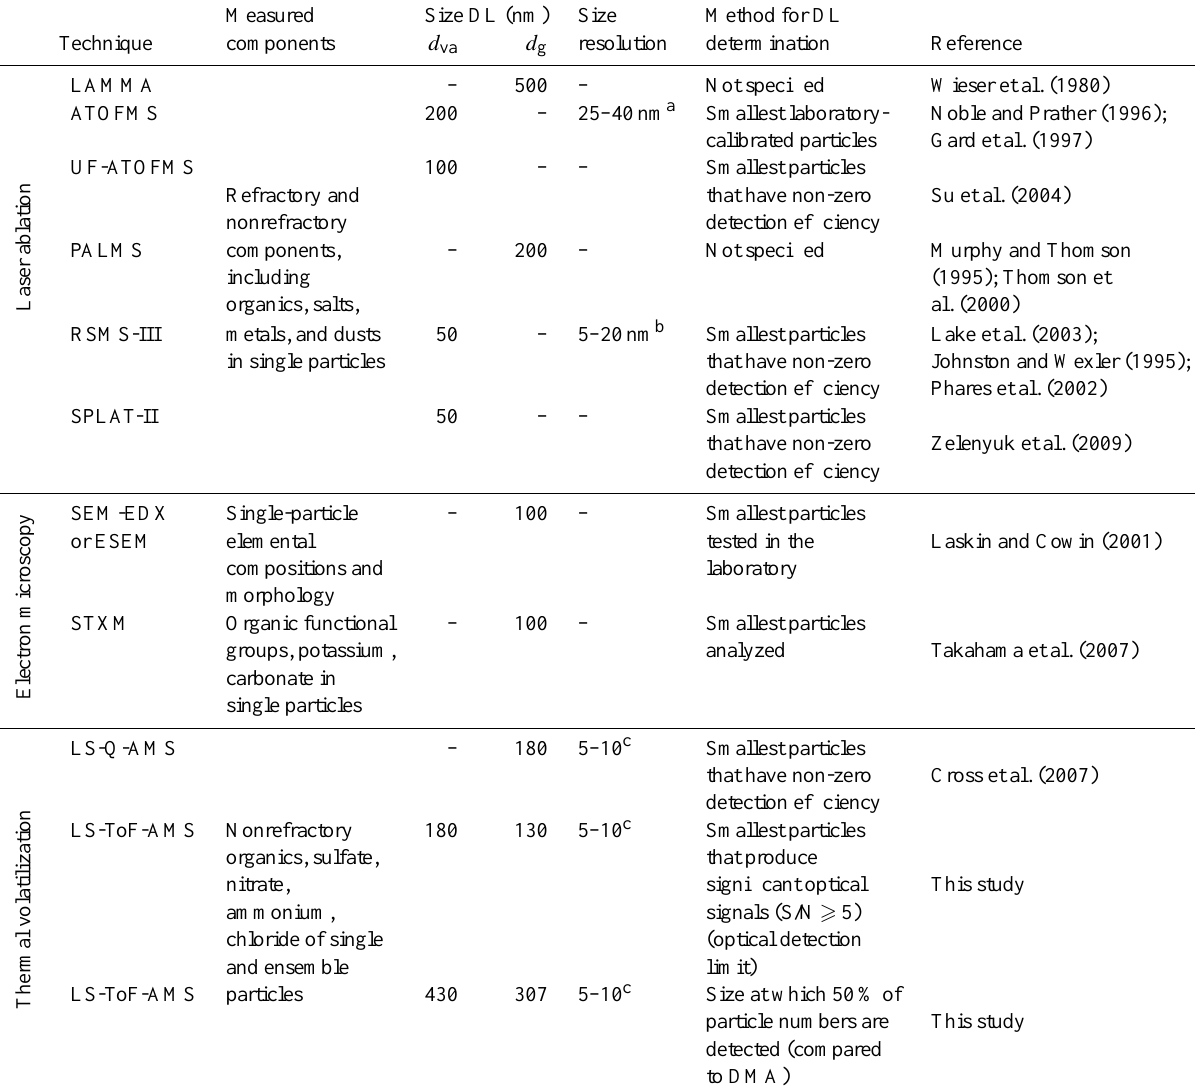
Table 1. Comparison of single-particle measurement techniques and their detection